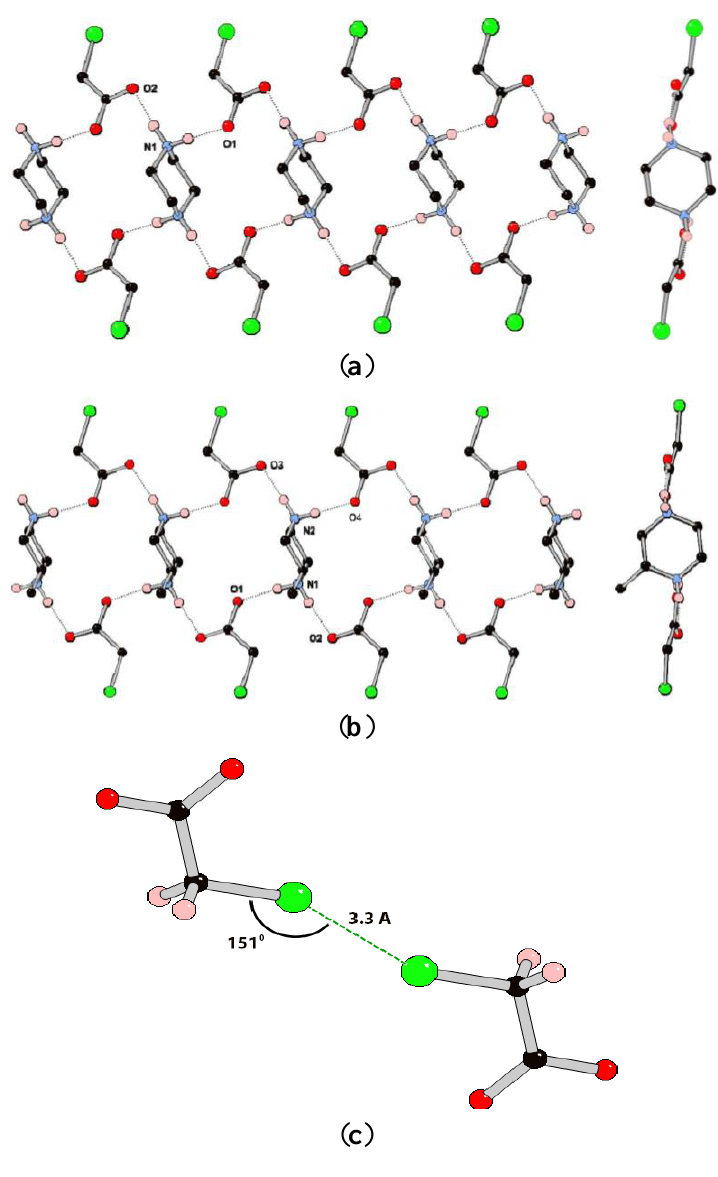
Figure 4. ( a ) Views perpendicular to and along part of the 1D hydrogen bonding chain in the structure of (pipH )(ClOAc) ( 3 ); ( b ) Views perpendicular to and along part of the 1D 2 2 hydrogen bonding chain in the structure of (MepipH )(ClOAc) ( 4 ); ( c ) The Cl···Cl 2 2 interaction between adjacent chloroacetate anions in the structures of 3 and 4 .